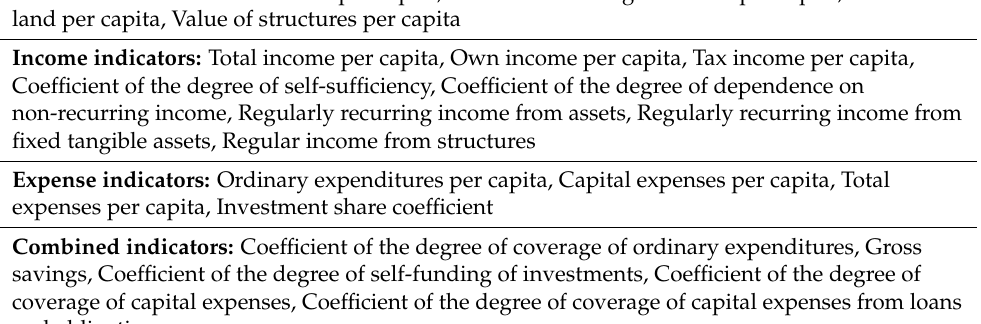
Table 3. Structure of indicators for the assessment of municipalities under the conditions of the Czech Republic (FAMA